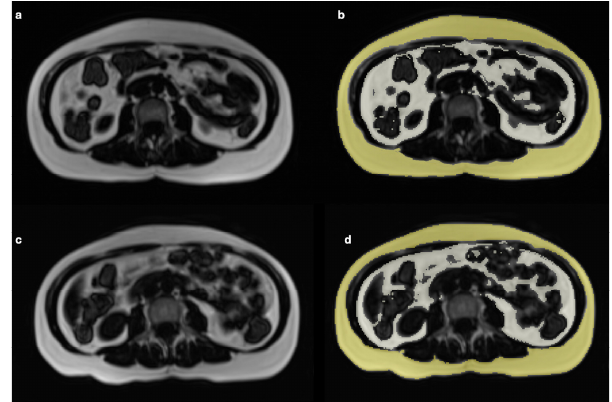
Figure 3. Pre-intervention ( a , b ) and post-intervention ( c , d ) magnetic resonance (MR) images were obtained at the L3 level. Adipose tissue appears white and non-adipose tissue appears dark on non-segmented images ( a , c ). Segmented images show visceral fat (VAT) in grey and subcutaneous fat (SAT) in yellow color. A decrease in subcutaneous fat and visceral fat is clearly observed.